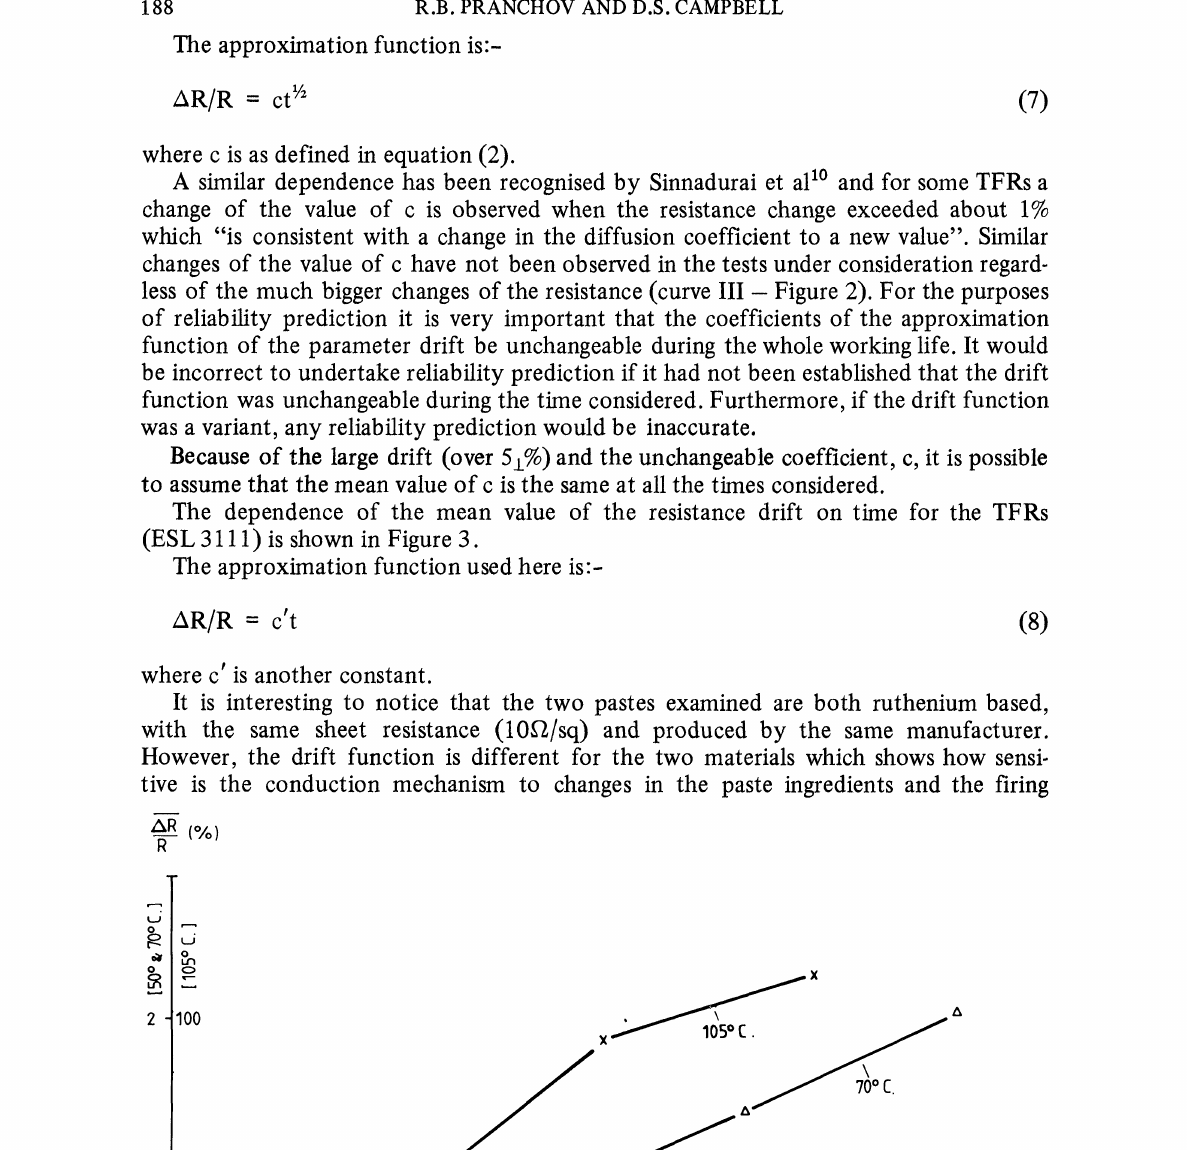
SX ’J X Mean value of resistance drift for TFRs (ESL 3111) at tee storage